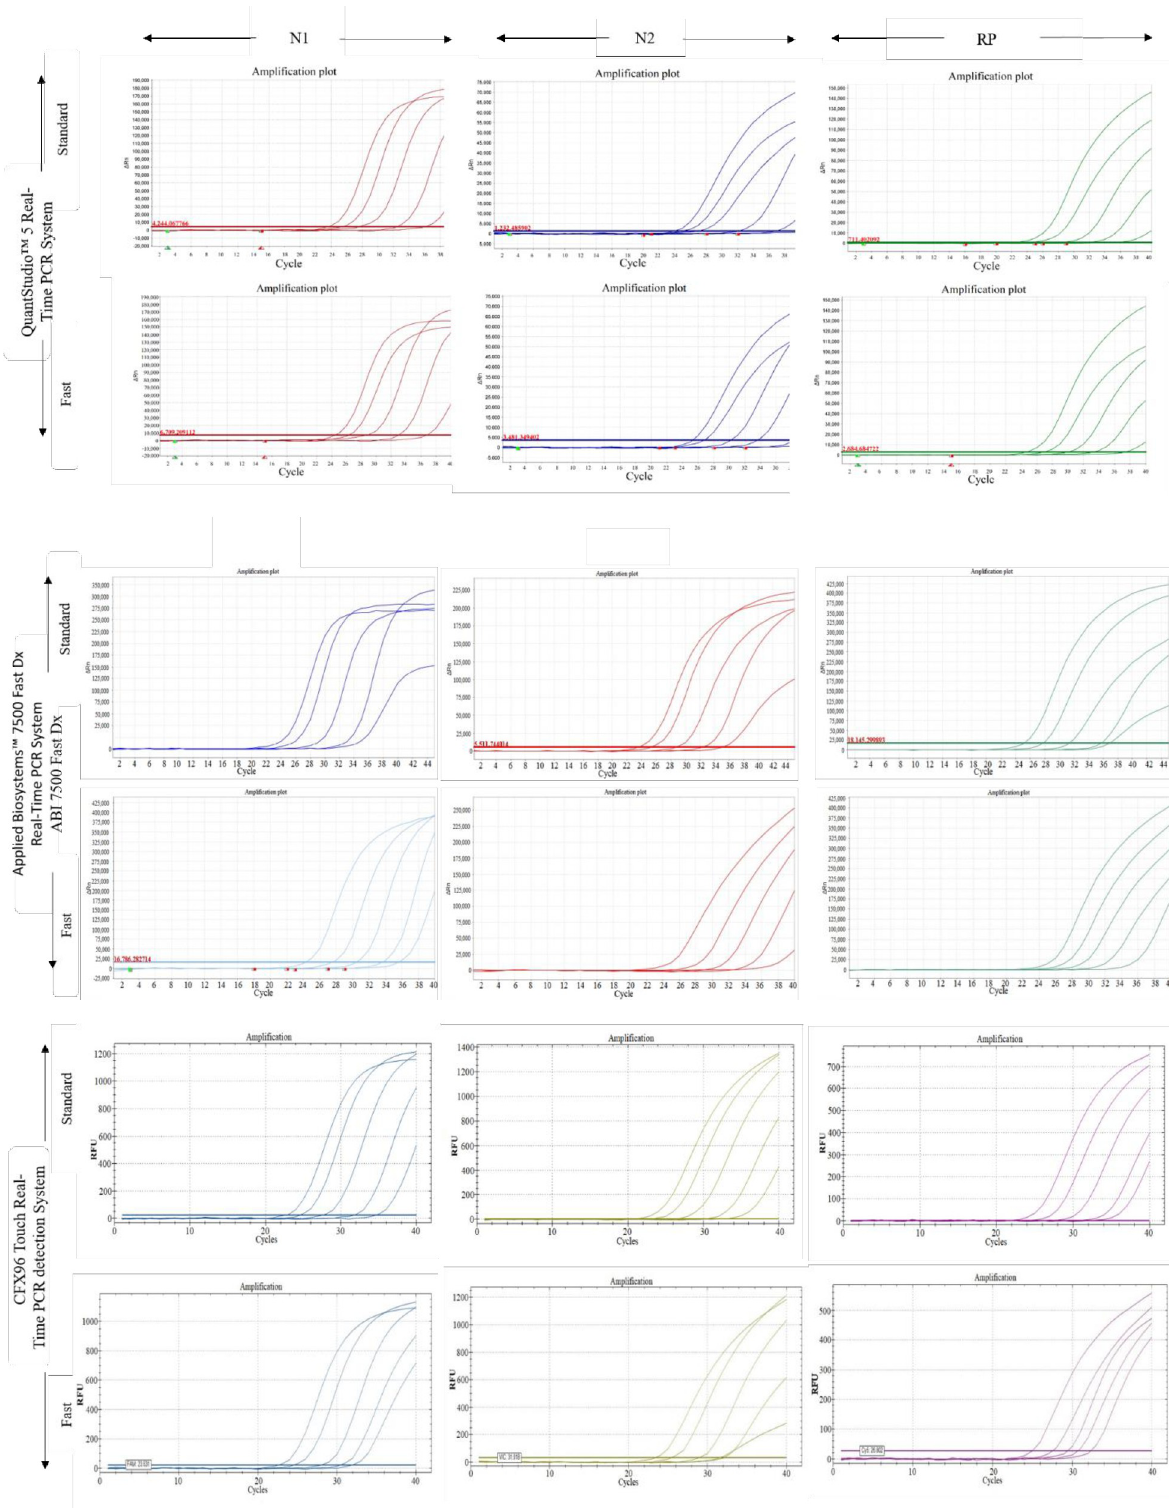
Fig 1. Fluorescence intensity curves of SARS CoV-2 targets, namely N1 (FAM) and N2 (VIC), and human RNase P (CY5) due to amplification using standard PCR and Fast PCR protocols.